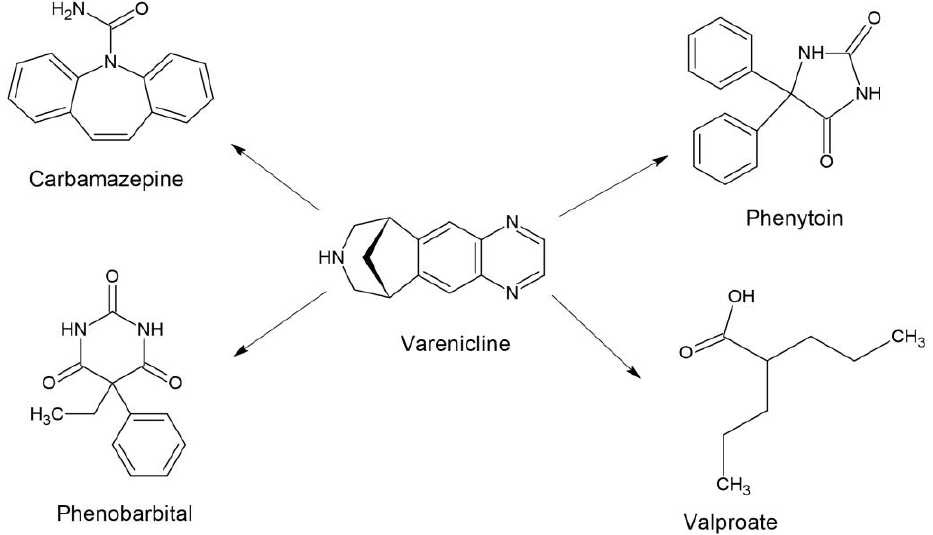
Figure 2. Chemical structures of the studied drugs.